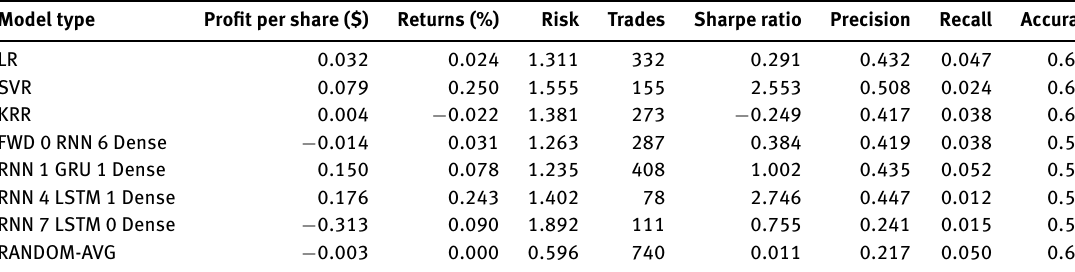
Table 10: 60-Min Regression Model Metrics on Testing